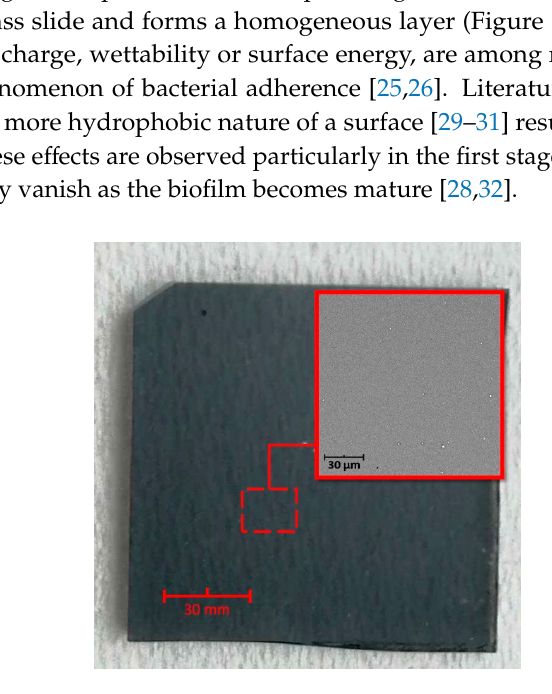
Figure 1. Homogeneity of a sputter-coated layer of platinum. Optical image of a Pt-coated glass slide and a SEM image as the inset.